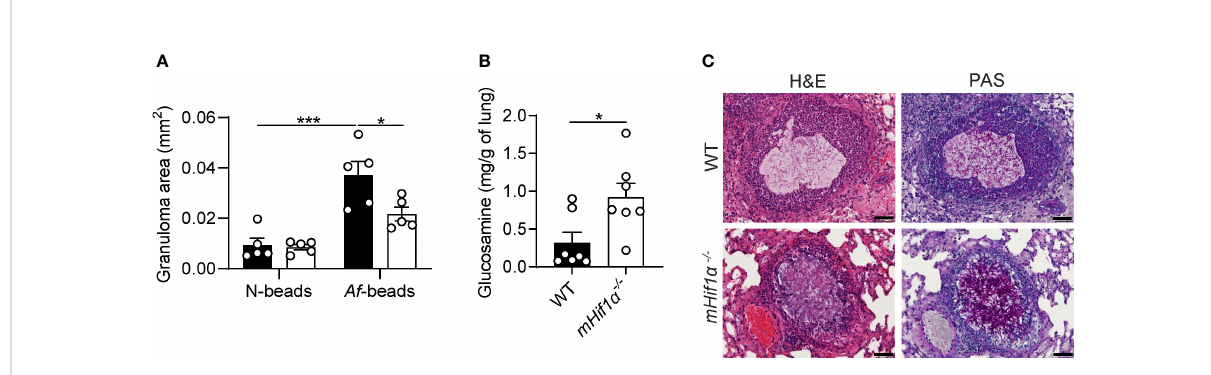
FIGURE 2 Myeloid deletion of HIF-1 a impacts fungal clearance and granuloma establishment. (A) Granuloma area around Af -beads and N-beads in wild- type (WT) and myeloid HIF-1 a -de fi cient ( mHif1 a -/- ) mice after 3 days post-infection (n = 5). (B) Fungal burden in the lungs of WT and mHif1 a -/- mice after 3 days post-infection with Af -beads (n = 7). (C) Representative lung sections from WT and mHif1 a -/- mice after 3 days post-infection with Af -beads stained with haematoxylin and eosin (H&E) and Periodic acid-Schiff (PAS). Scale bar represents 50 m m. *P < 0.05; ***P <